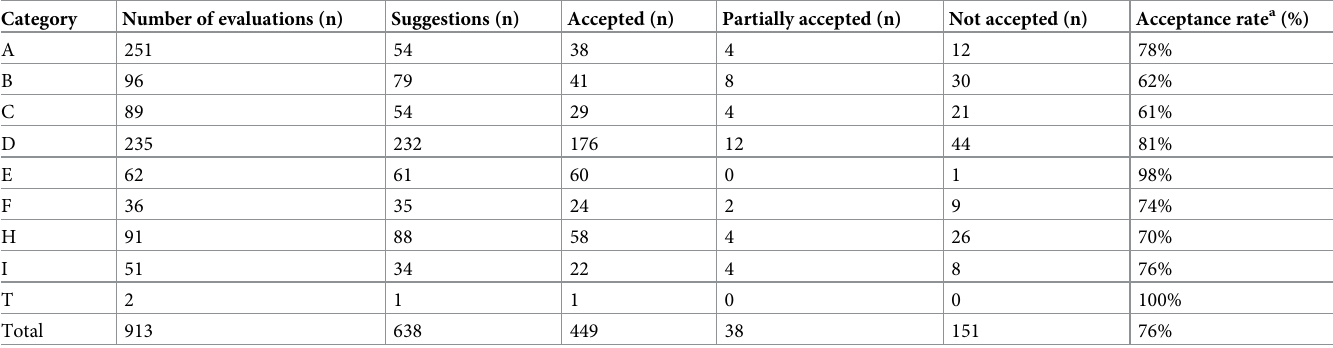
Abbreviations: A, Appropriate; B, Better choice; C, Culture; D, De-escalation; E, Escalation; F, Fitting dose; H, Halt; I, Indication document; T, Time out.